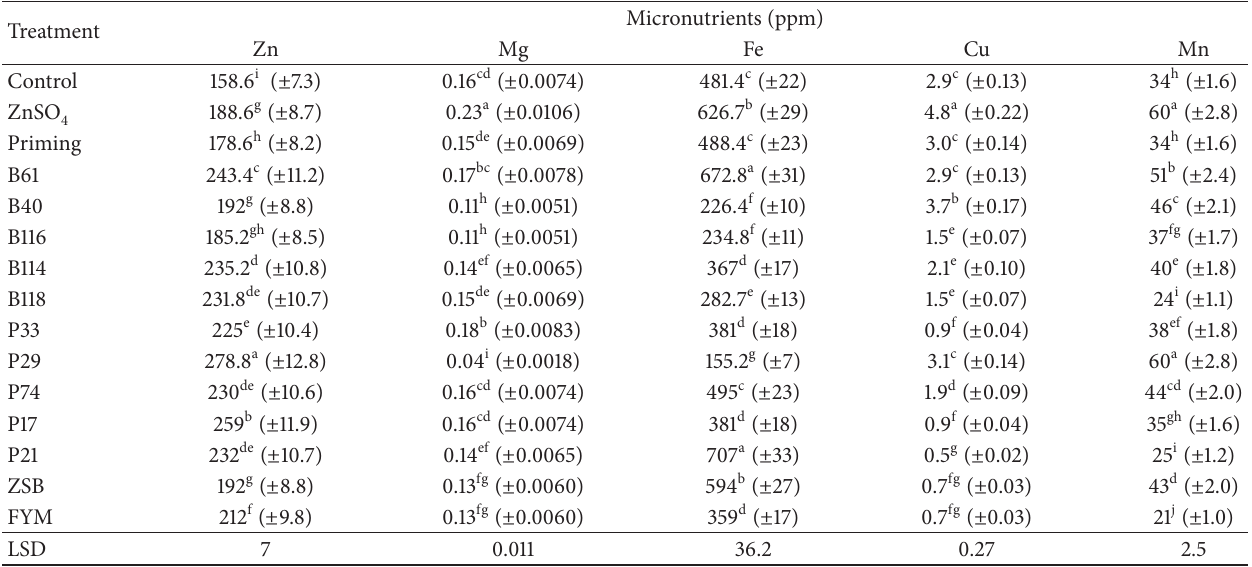
Table 4: Micronutrients uptake pattern of maize, seed treated with ZSBs, and inorganic source of zinc. Treatment